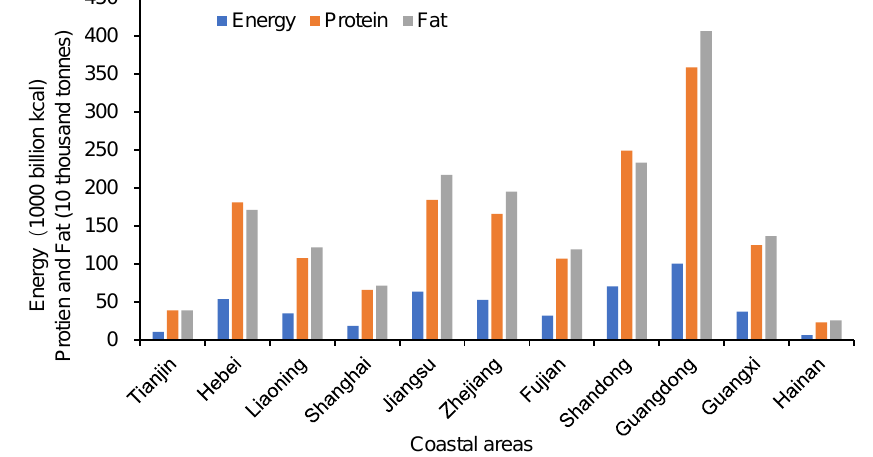
Figure 2. Nutrient consumption in coastal areas of China.